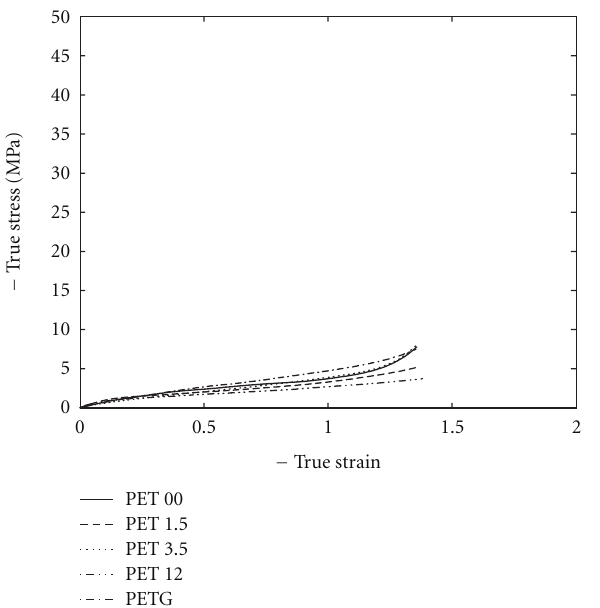
Figure 5: Material comparison, plane strain compression at 90 ◦ C and 0.005/s.